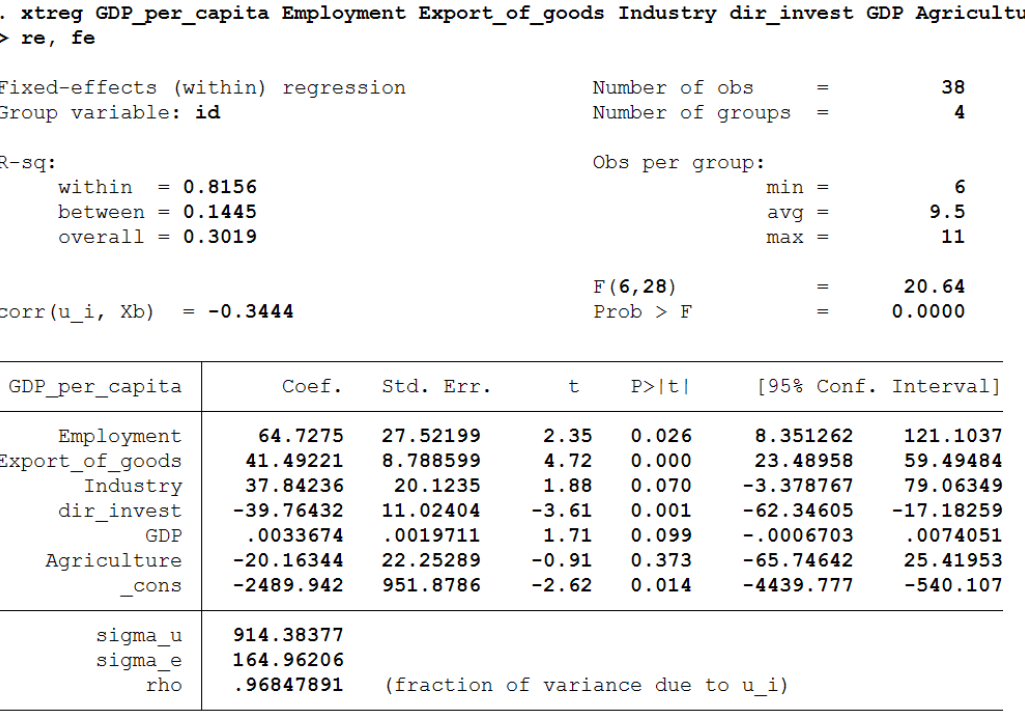
Figure 5. Results of estimating the influence of the share of GDP created in the agricultural sector on the country’s economic development level